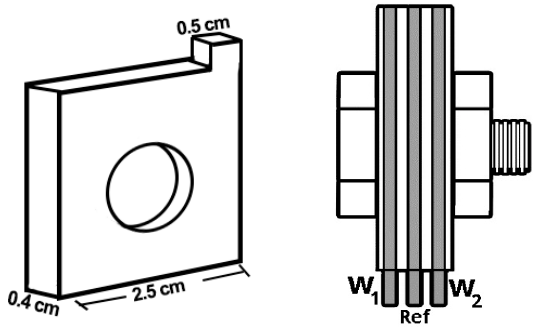
Figure 1. ACM monitors construction.